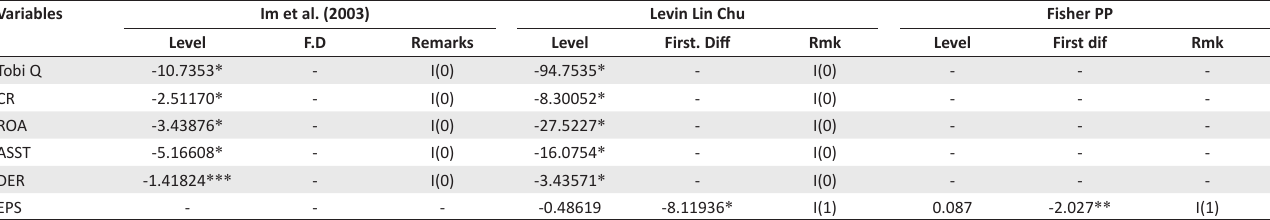
TABLE 3: Panel unit root test.